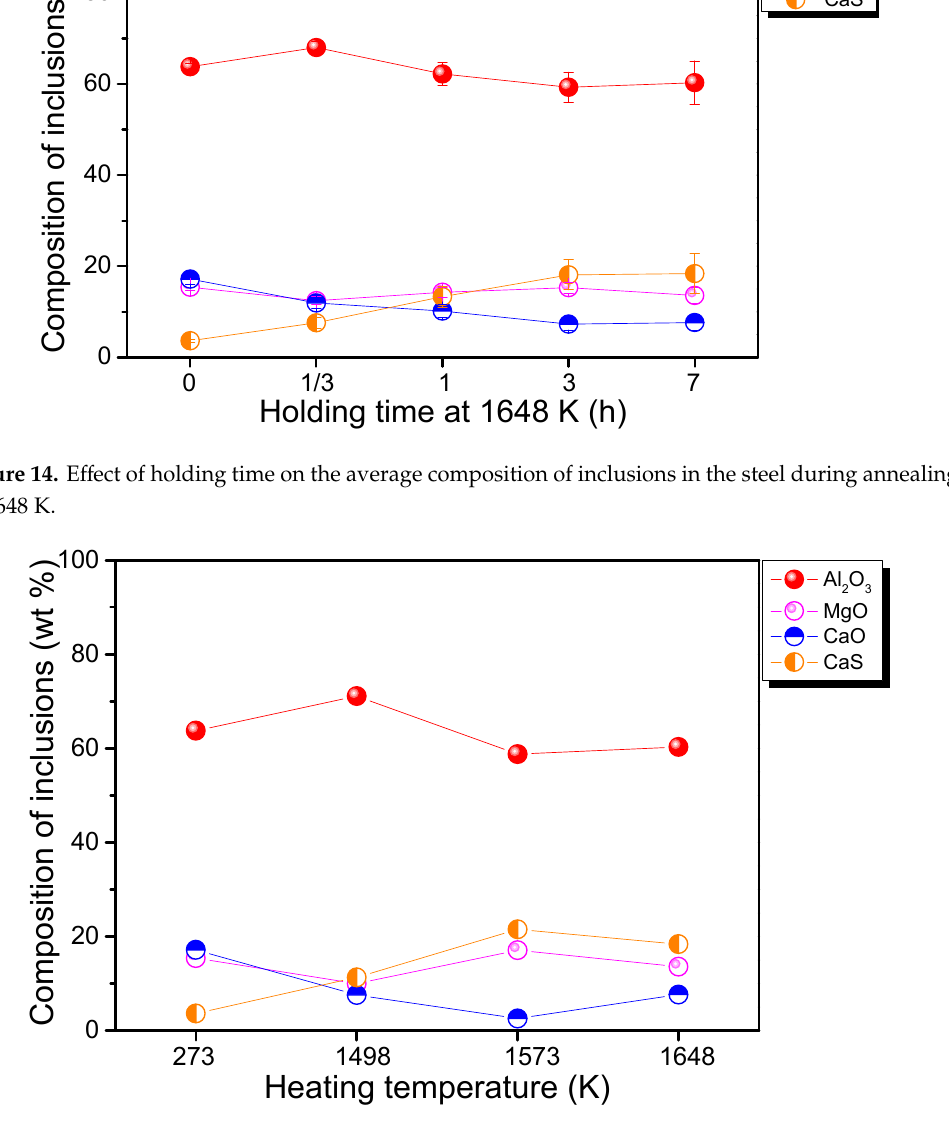
Figure 15. Effect of temperature on the average composition of inclusions in the steel with same holding time (7 h).